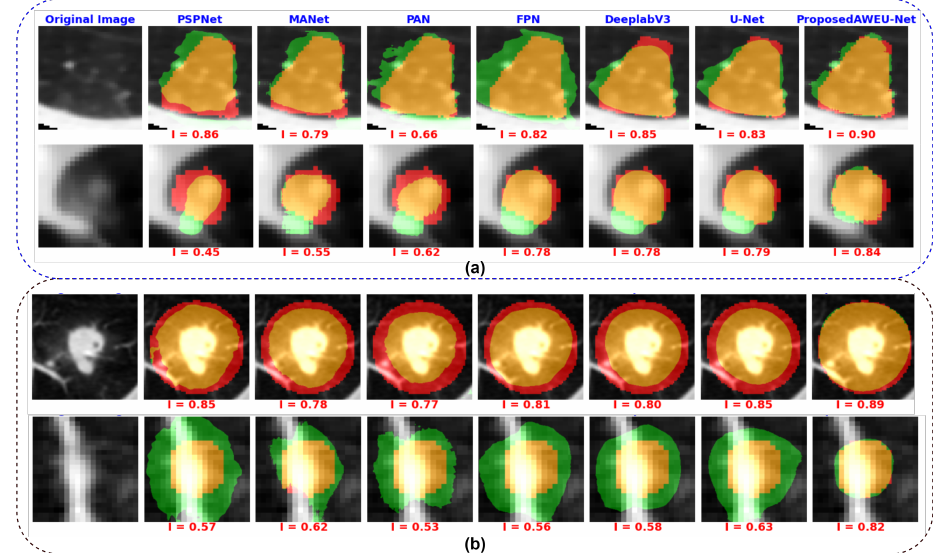
Figure 11. Examples of segmentation results by different state-of-the-art models. ( a ) Segmentation results on the LIDC-IDRI dataset and ( b ) segmentation results on the LUNA16 dataset. The colors of the segmentation visualization results are presented as follows: TP (orange), TN (background), FP (green), and FN